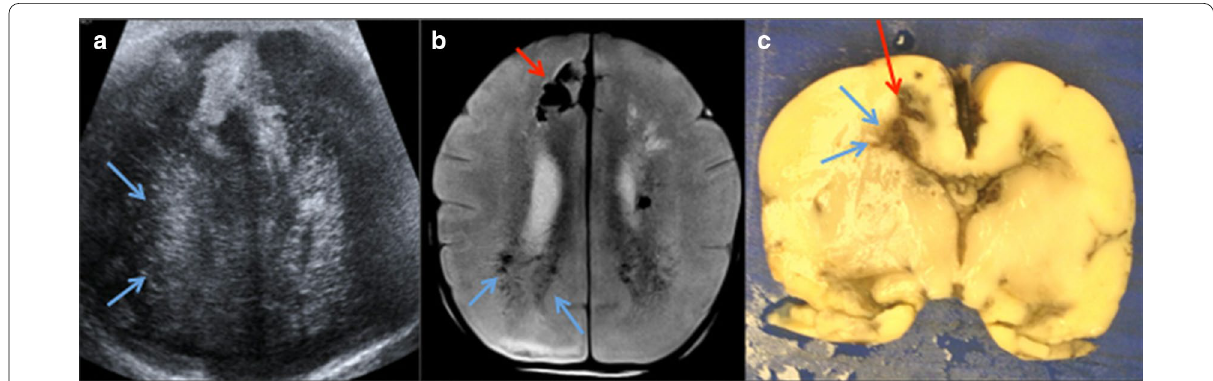
Fig. 10 Intracranial haemorrhage in a 29‑week premature newborn. a Ultrasound, ( b ) axial T2W MRI, ( c ) pathology showing periventricular (blue arrows) and frontal haemorrhage (red